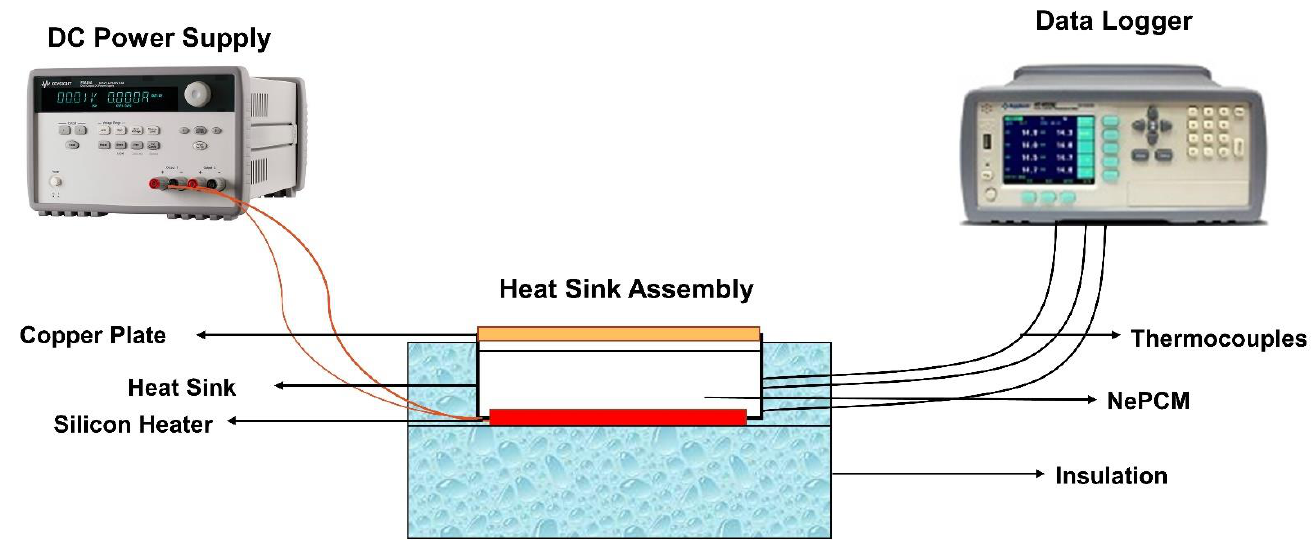
Figure 2. Test setup for thermal performance of NePCM-based heat sinks.